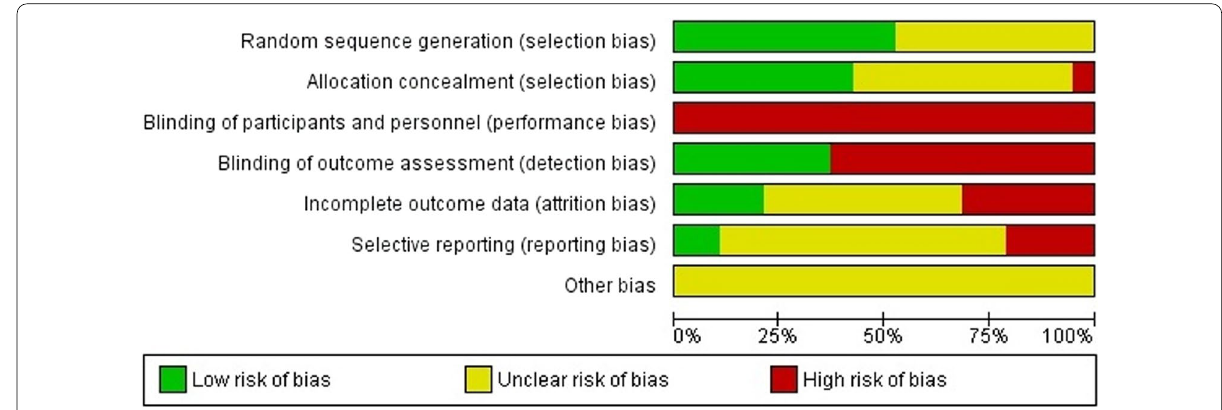
Fig. 2 Forest plot of the effect of VR on fine motor coodination in children with